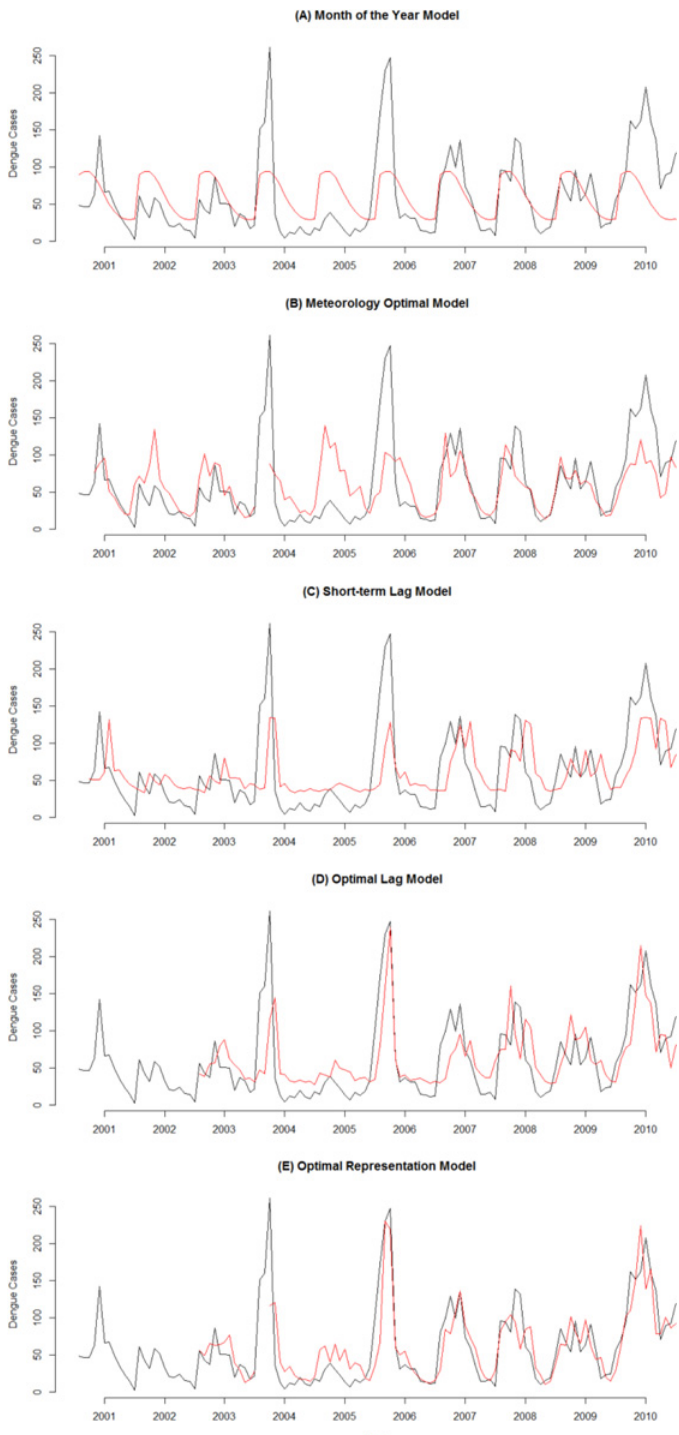
Fig 5. Monthly Observed and Predicted Dengue Cases from 2001 – 2010. Black line represents observed dengue cases and red line represents predicted cases. The vertical axis shows dengue cases and the horizontal axis denotes time in month from January 2001 to December